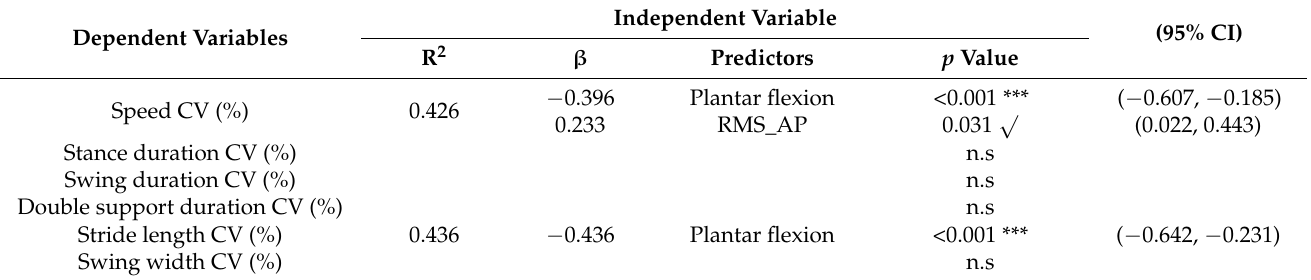
Table 4. Summary of results of stepwise regression analysis of gait variability in the elderly ( n =